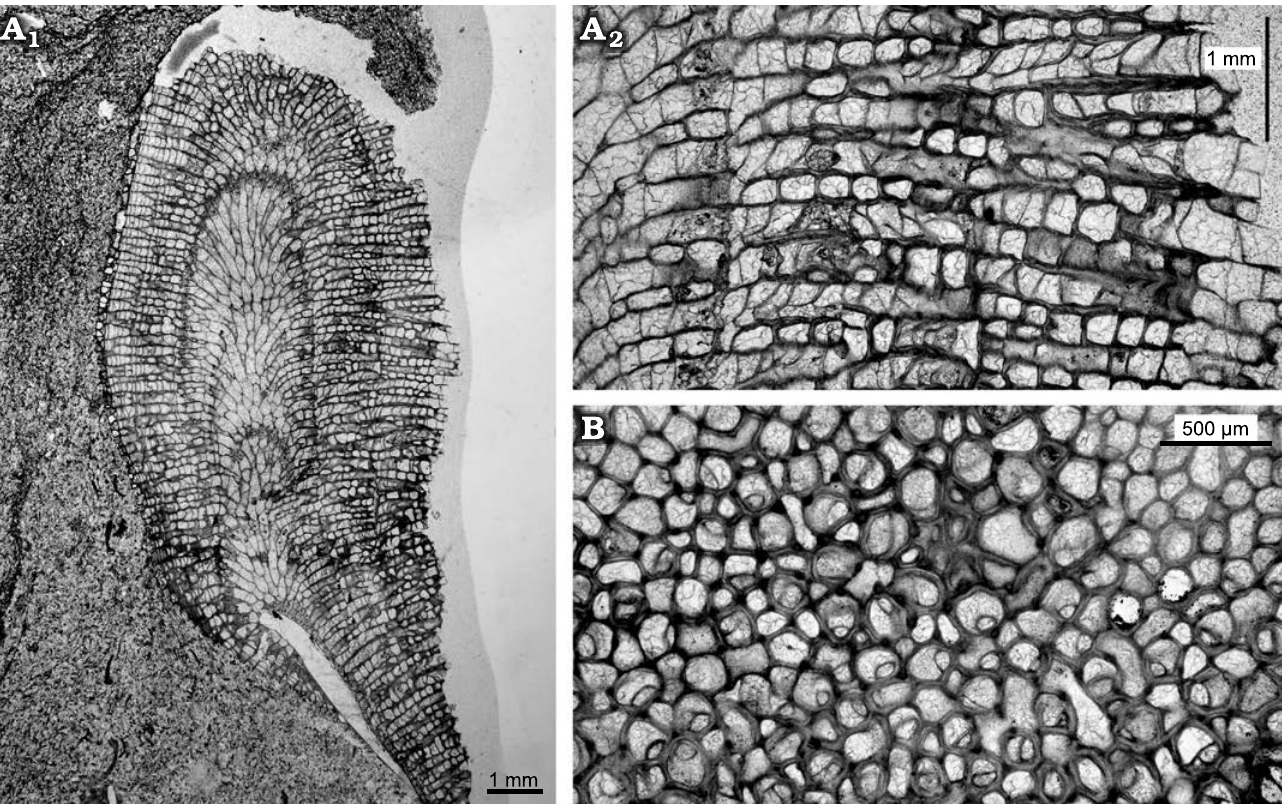
Fig. 5. Thin sections of trepostome bryozoan Homotrypa cochlea sp. nov. from Upper Leintwardine Formation, Ludfordian, upper Ludlow, Silurian; Delbury Quarry, Shropshire, UK. A . Holotype, NMW 2019.21G.2.3, ramose colony form (A 1 ), thick mesozooecia walls connected by diaphragms, con- tinue cystose shape of earlier growth (A 2 ). B . NMW 2019.21G.2.4, autozooecia rounded in cross-section, some irregularly shaped.